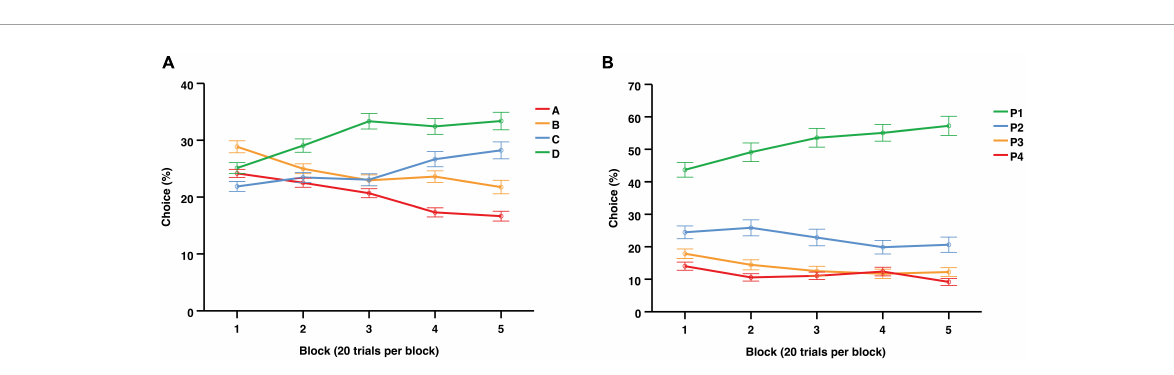
FIGURE3 Average choices (%) per 20-trial blocks over the entire session of the IGT (A) and the first 100 trials of the rGT (B) . Data are presented as mean ± 1 standard error